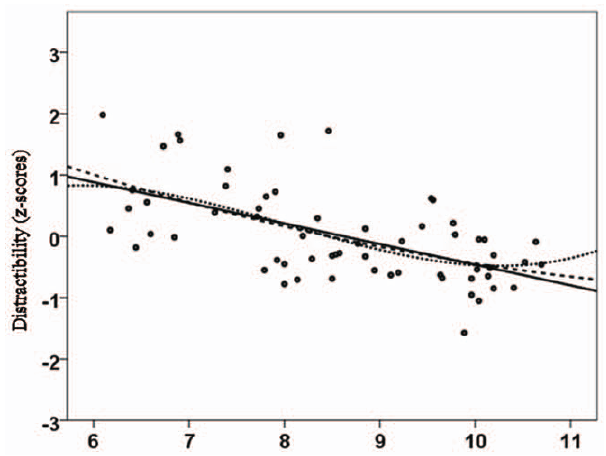
Figure 2. Correlation between age (yrs.) and distractibility as assessed by the KITAP [ 18,33 ] . A linear trend was indicative of a reduction in distractibility with increasing age. There was no quadratic trend, and a cubic trend was indicative of a plateau (decrease – plateau) for ages greater than 10 years.